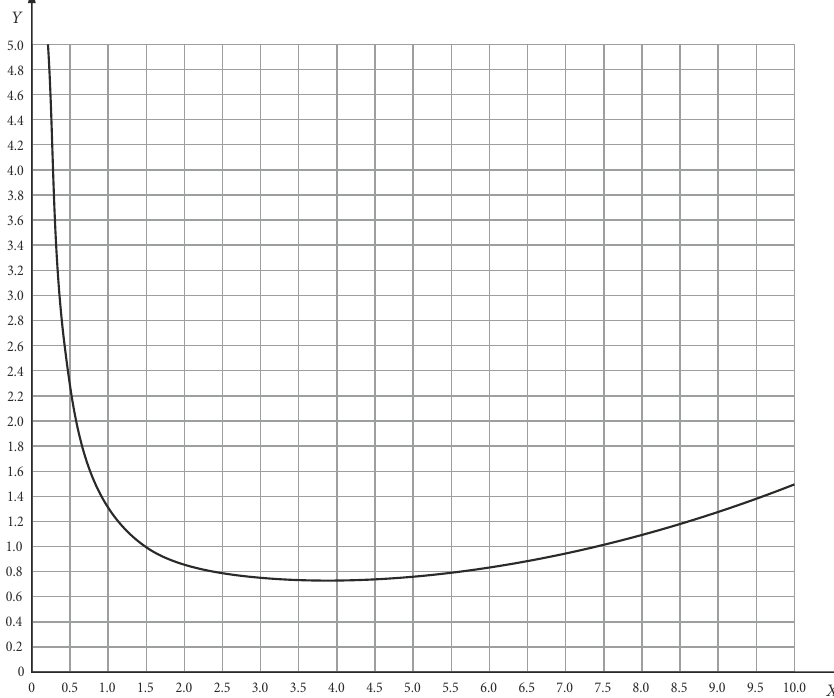
Figure 2. Farm income growth rate ( Y ) as a function of technical productivity ( X ) as in equation 3 (source: own calculations at the basis of EU-15 panel data from